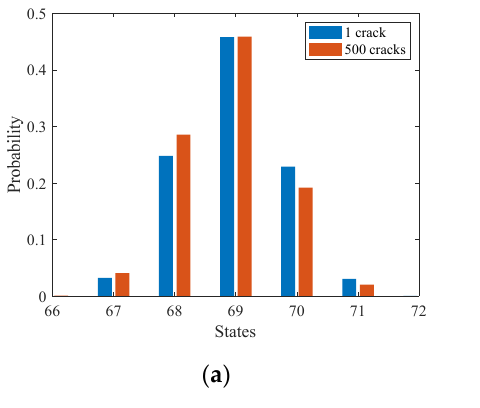
Figure 17. Comparison of posterior probability distributions of fatigue crack size considering the inspection data of only one crack and 500 cracks. ( a ) Fatigue crack size for current time step. ( b ) Fatigue crack size for future time step.